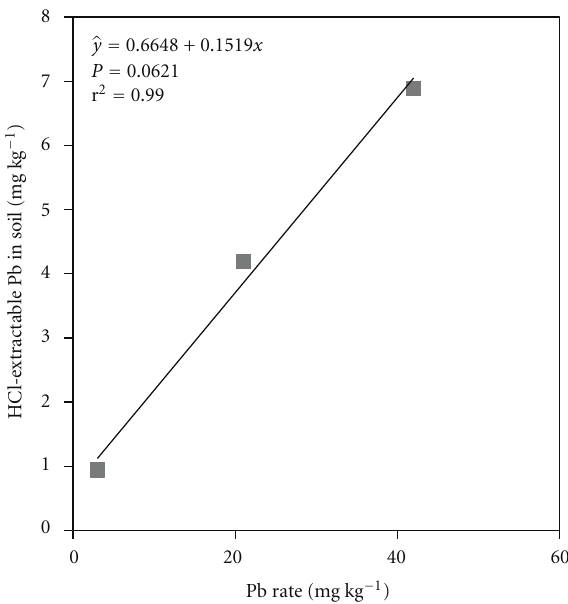
Figure 1: HCl-extractable Pb in soil as a function of Pb rates applied with sewage sludge varying content